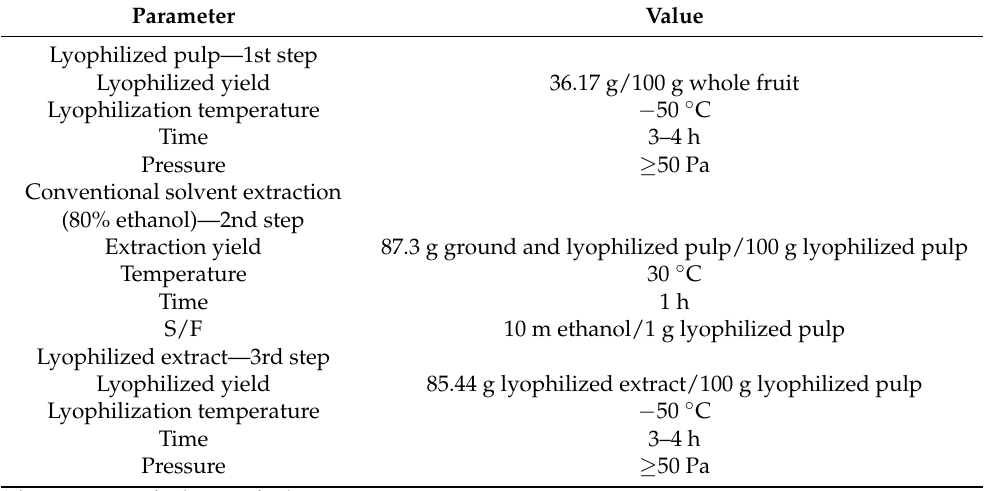
Table 1. Experimental data used to simulate the single-stage process by conventional solvent extrac- tion